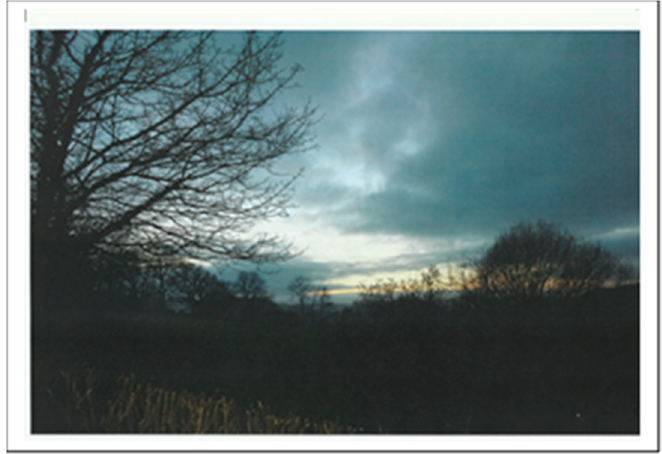
Figure 6. Photograph taken by Beth of the sun breaking through